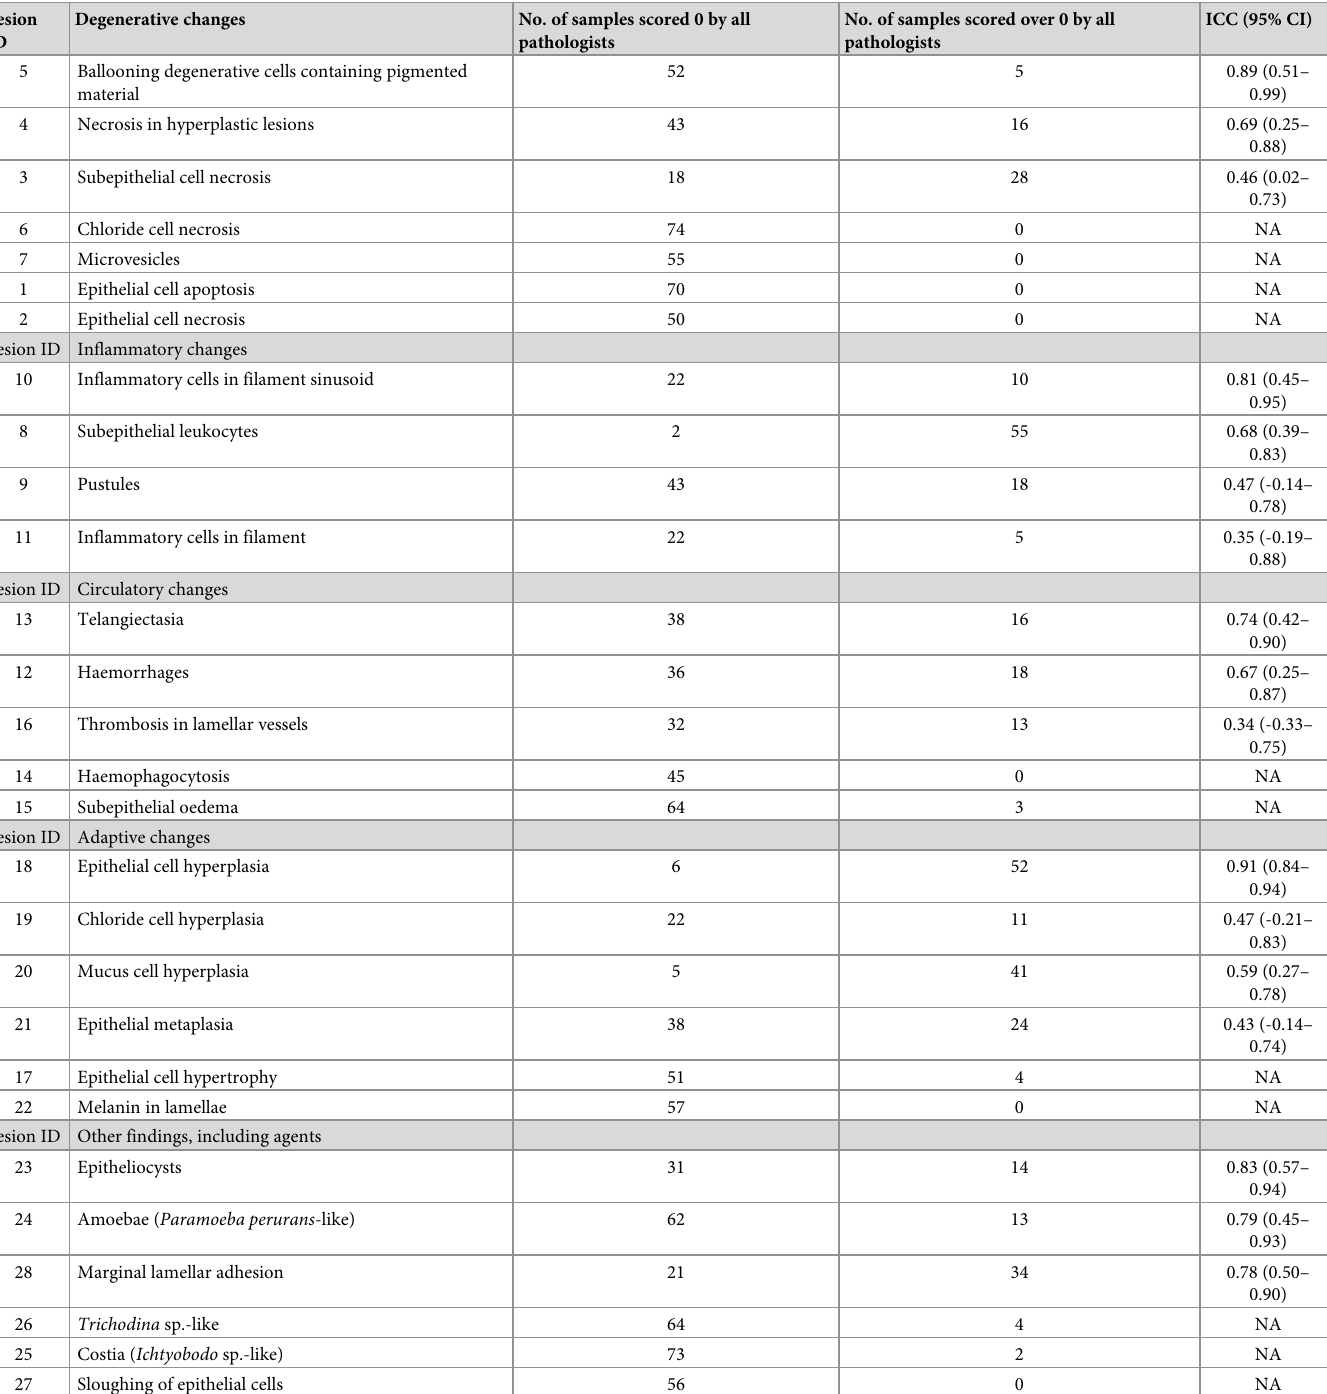
Table 3. Overview of inter-observer scoring agreement among the three pathologists. The level of agreement for each histopathological parameter was assessed by esti- mation of Intra-class Correlation Coefficient (ICC = ranges from– 1 to 1). ICC values of < 0.40 indicates poor agreement, 0.40–0.59 fair agreement, 0.60–0.74 good agree- ment, and 0.75 and 1.00 as excellent agreement. CI: confidence